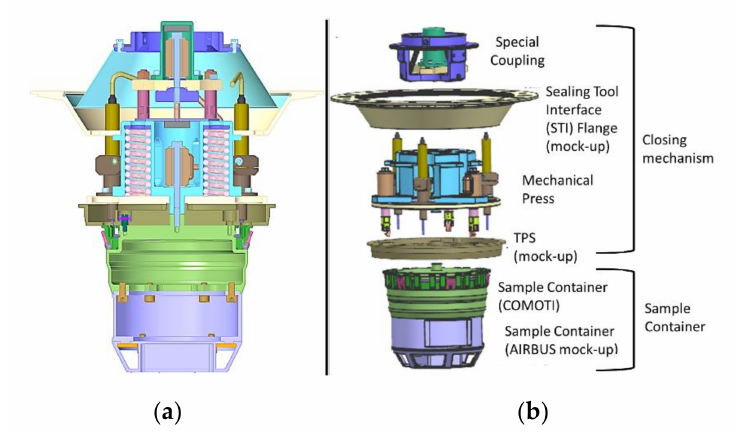
Figure 7. Closing Mechanism equipped with SC: ( a ) section, ( b ) exploded view.